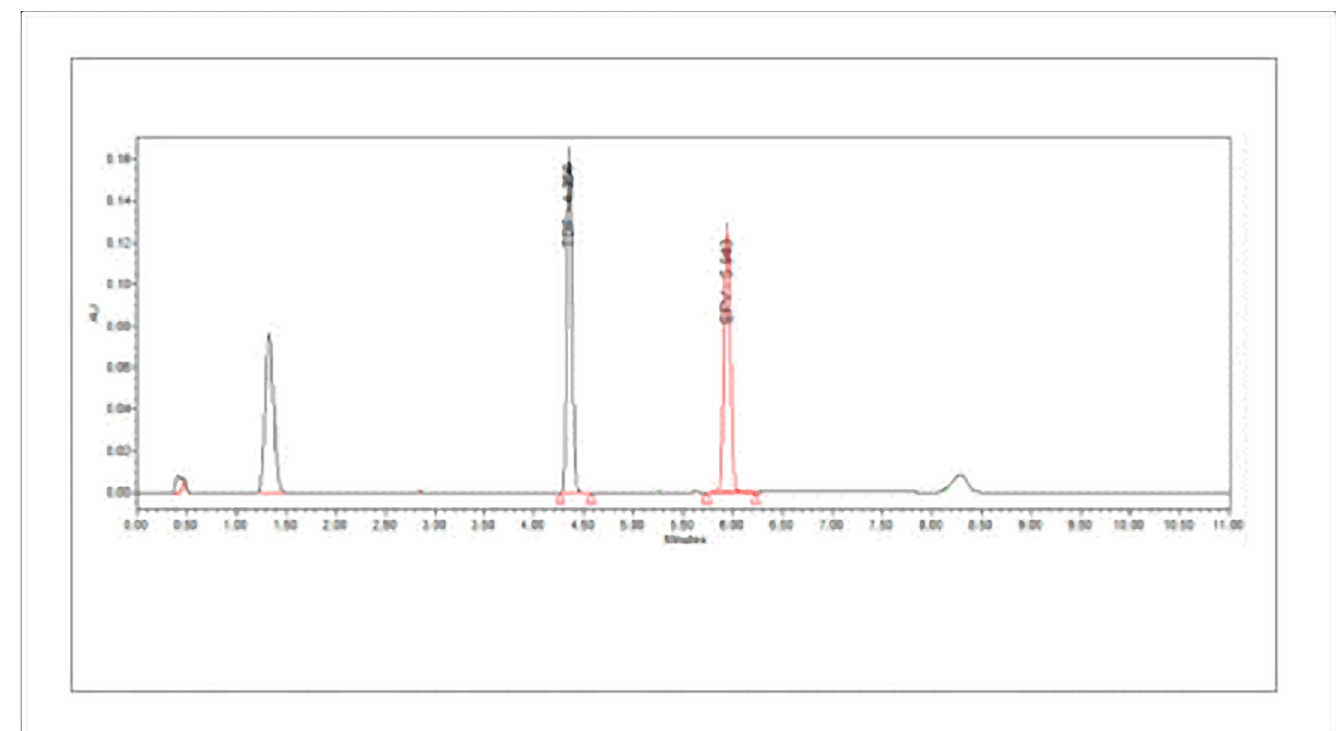
Fig 5. Chromatogram for specificity